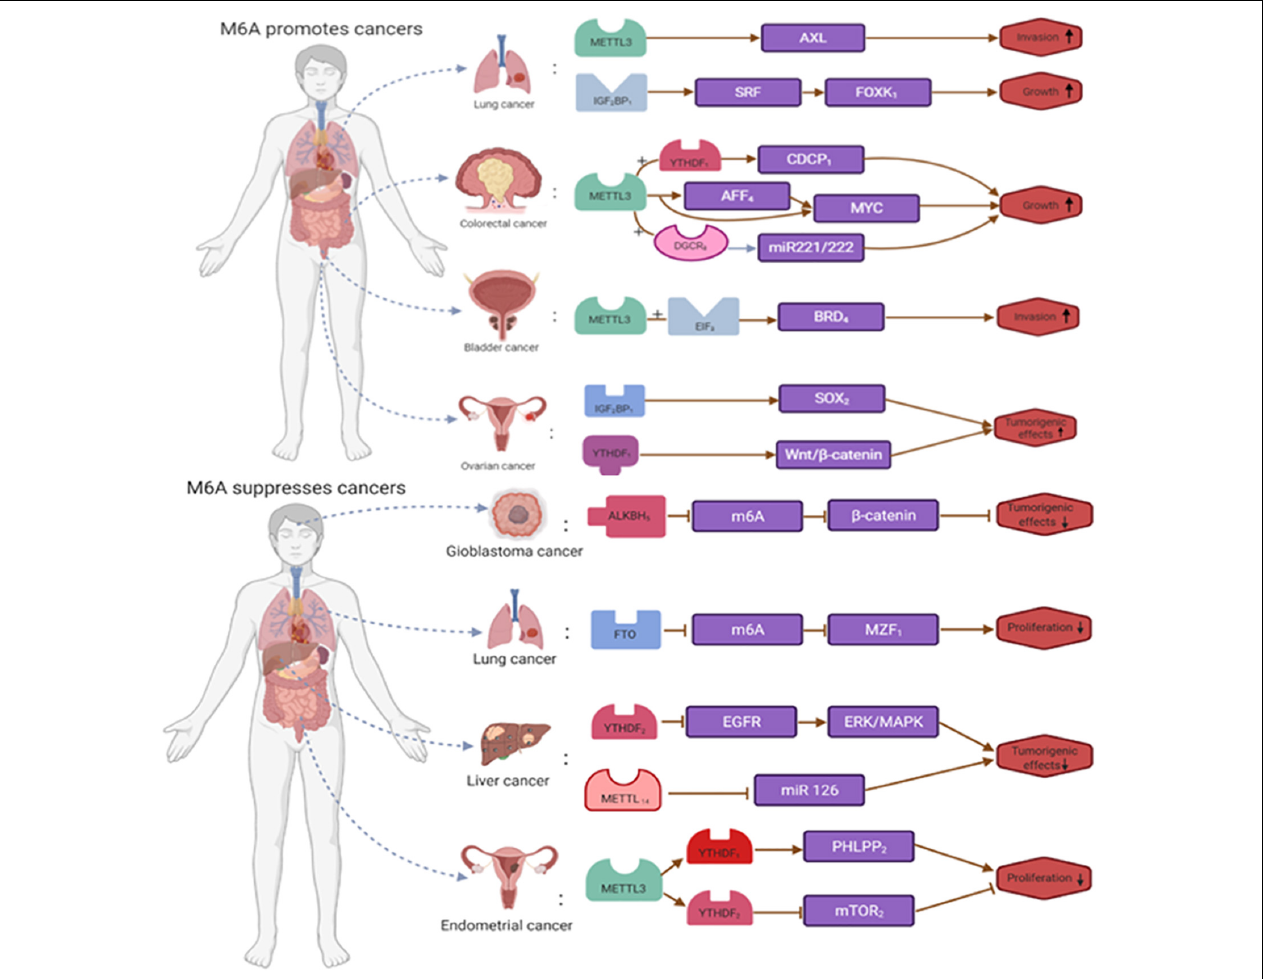
FIGURE 4 | The dual roles of m6A RNA modification in cancer. m6A is modified to regulate the expression of tumor-related genes. m6A RNA modification promote the occurrence and development of tumors by enhancing the expression of tumor-related genes or inhibit the occurrence and development of tumors by inhibiting the expression of tumor-related